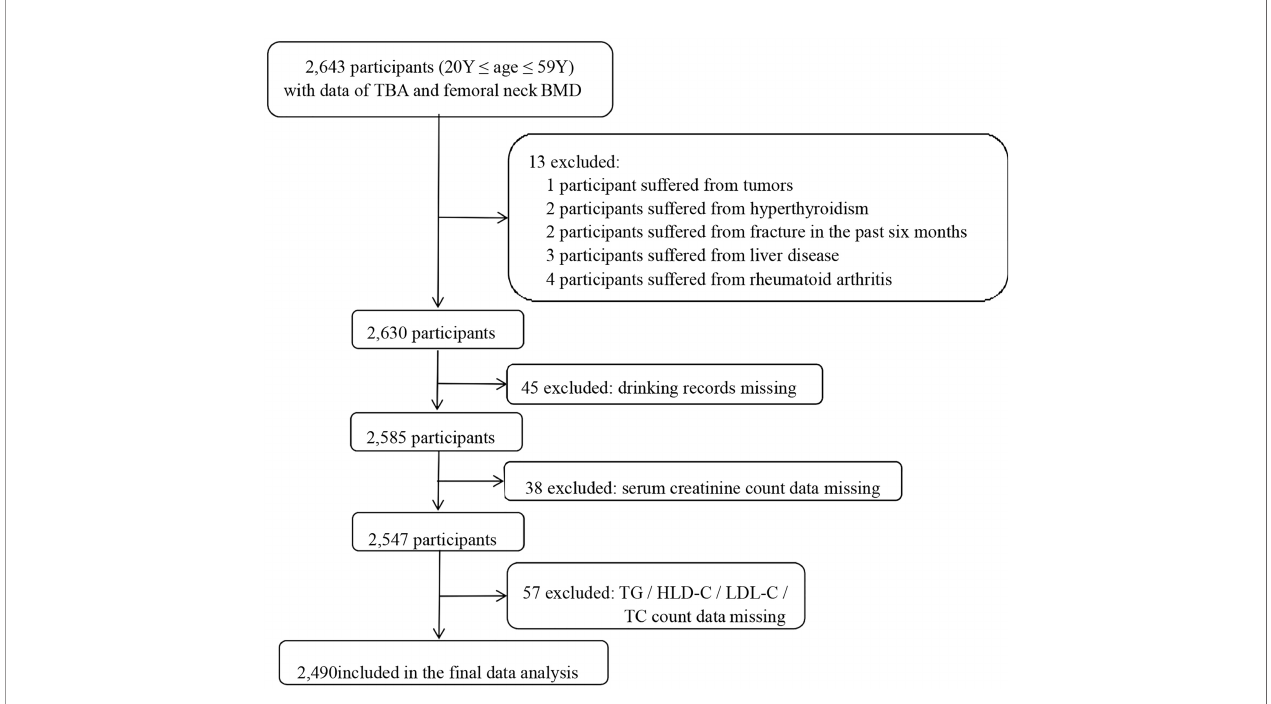
FIGURE 1 | Flow chart showing the selection process of the study